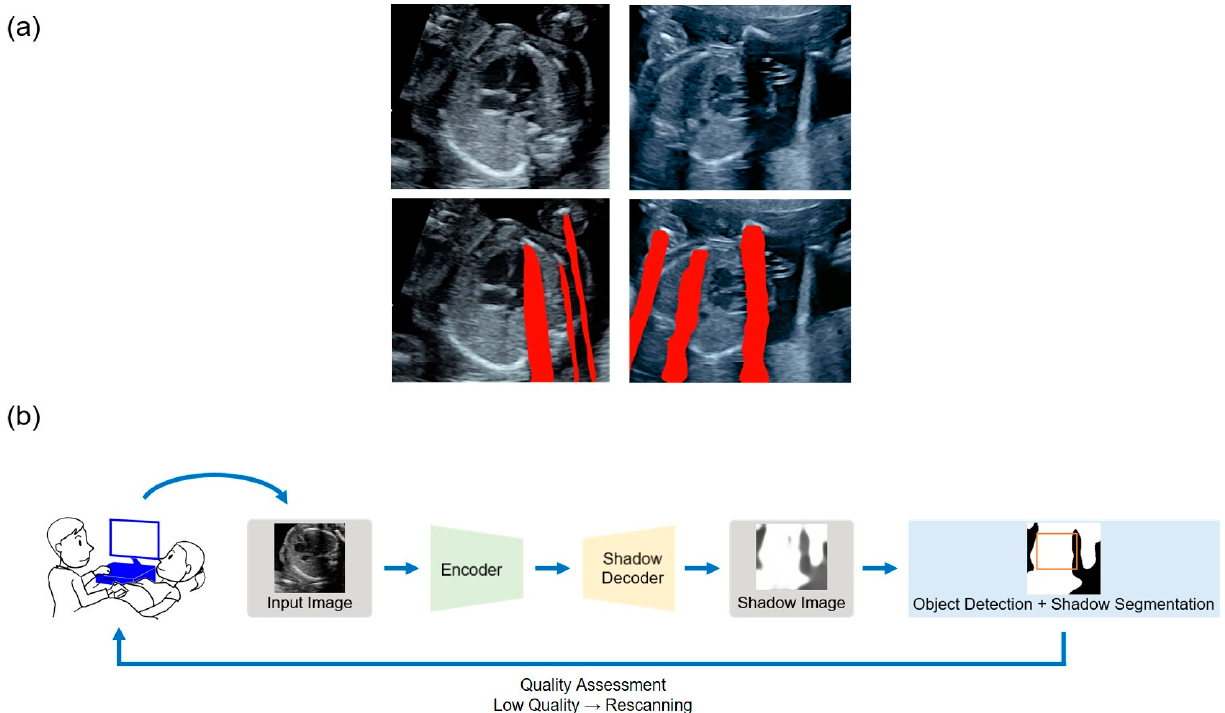
Figure 1. Acoustic shadow detection: ( a ) The red areas represent the segmented acoustic shadows using the semi-supervised approach [43]. ( b ) As a candidate for clinical application, examiners can evaluate whether the current acquired US imaging is suitable for diagnosis in real time. In the case of low image quality, rescanning can be performed in the same examination time. This application may improve the workflow of examiners and reduce the patient burden.